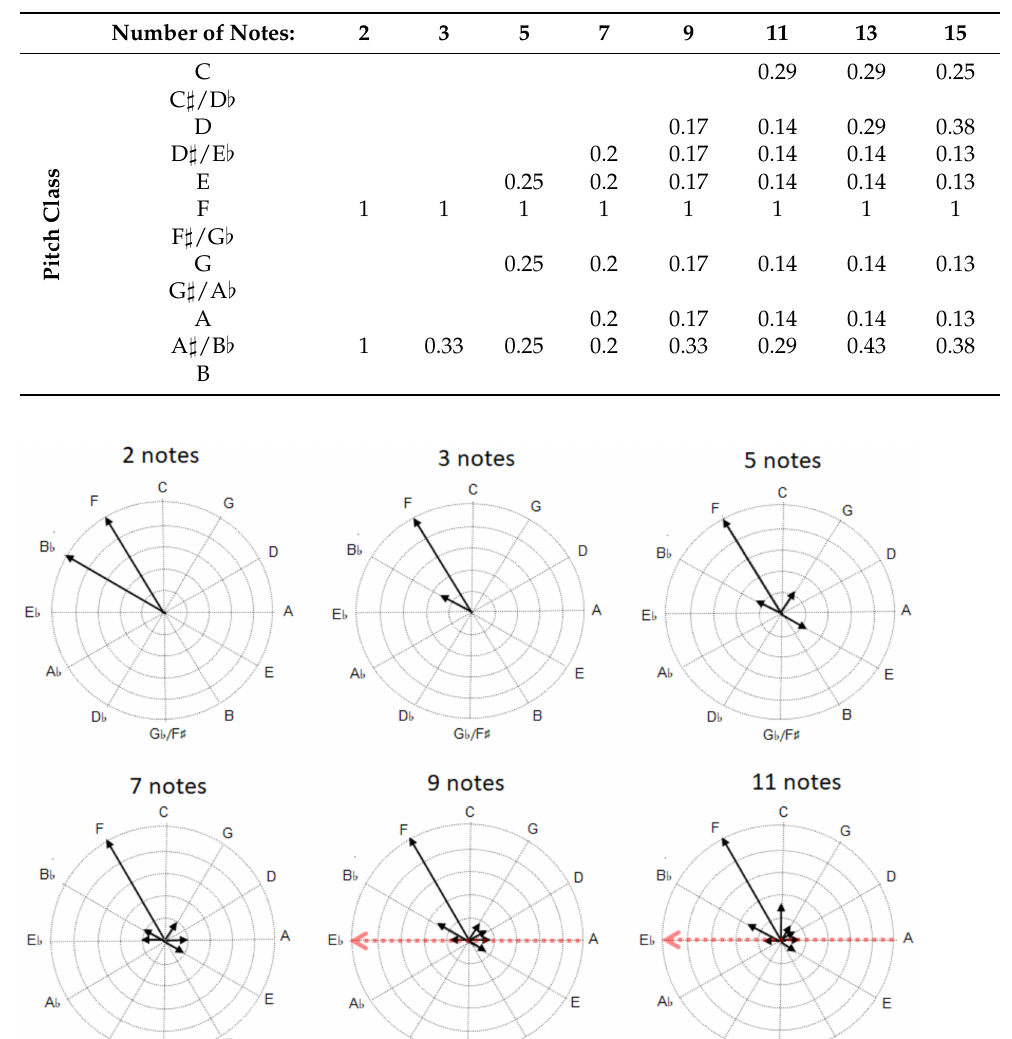
Table 3. The lengths of pitch-class vectors making up the music signatures corresponding to the music notation shown in Figure 12, obtained for different numbers of initial notes.